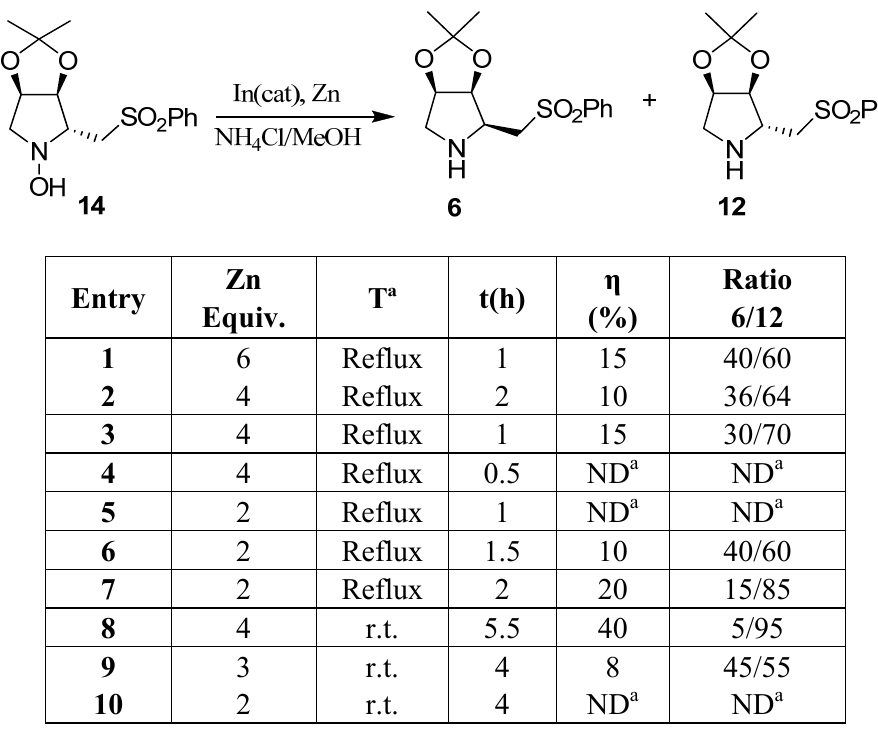
Table 1. Reduction conditions of hydroxylamine 14 to pyrrolidines 6 and 12